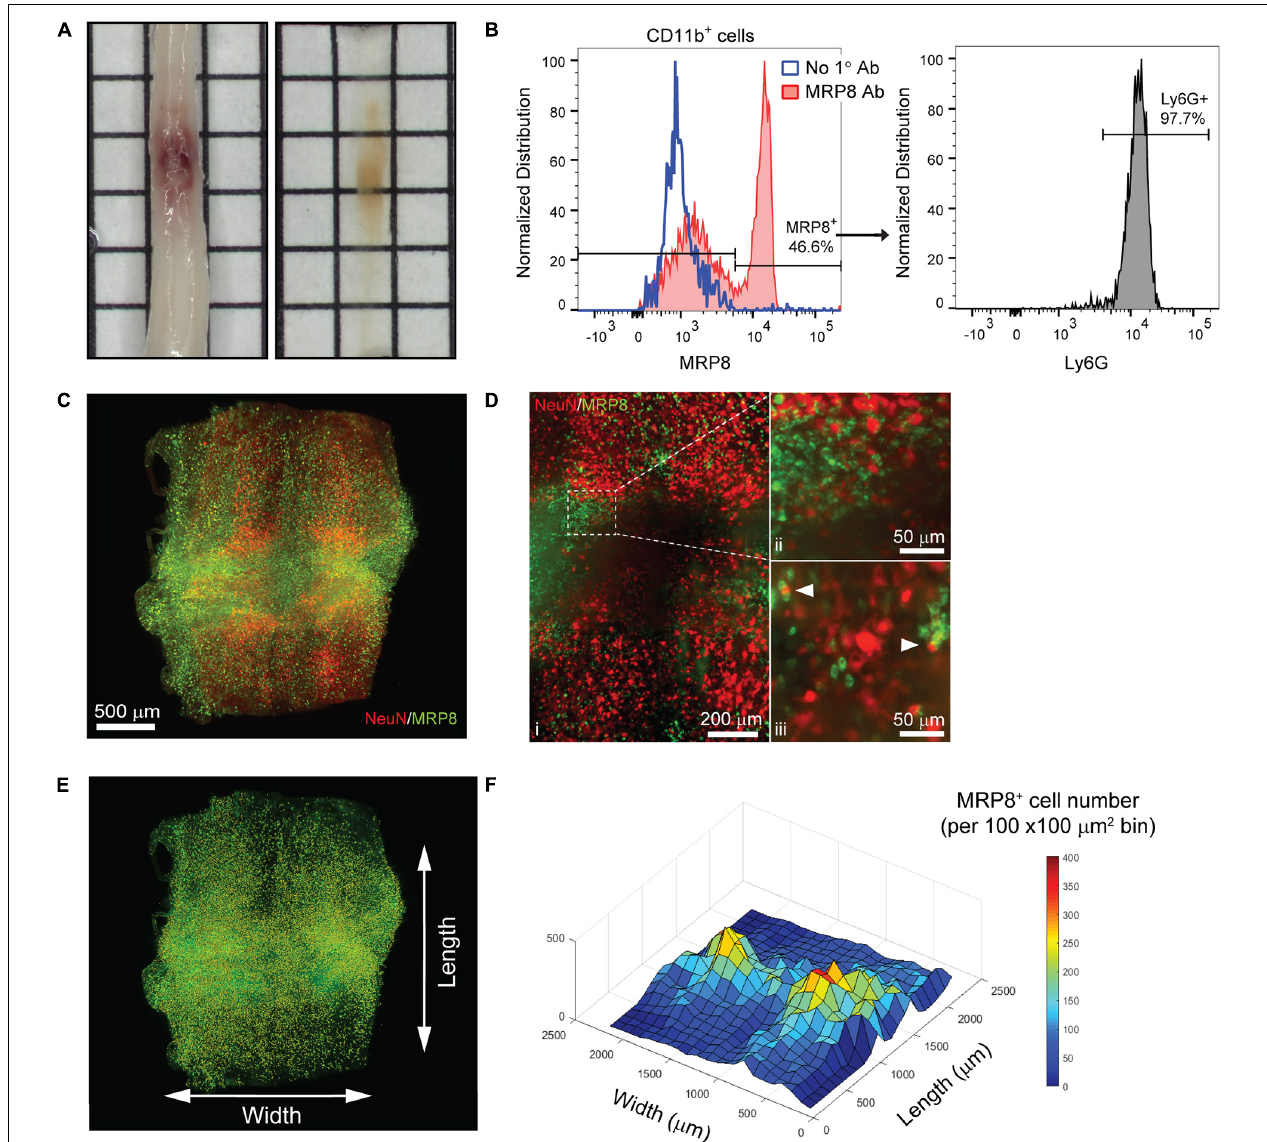
FIGURE 3 | 3D evaluation of inflammation in the acutely injured spinal cord using PACT clearing and lightsheet microscopy. (A) PACT clearing of the acutely injured spinal cord from a C57Bl/6 mouse. (B) Representative flow cytometry histograms showing Ly6G expression in CD11b + /MRP8 + cells in the spinal cord at 1 day post-SCI ( n = 1). (C) 3D projection of MRP8 and NeuN IF labeling in the cleared spinal cord at 1 day post-SCI. (D) Maximum intensity projection of MRP8 and NeuN IF labeling at the SCI site (i) . Loss of NeuN + neurons and MRP8 + cells is observed toward the lesion epicenter (ii) . Single z-plane images show MRP8 +